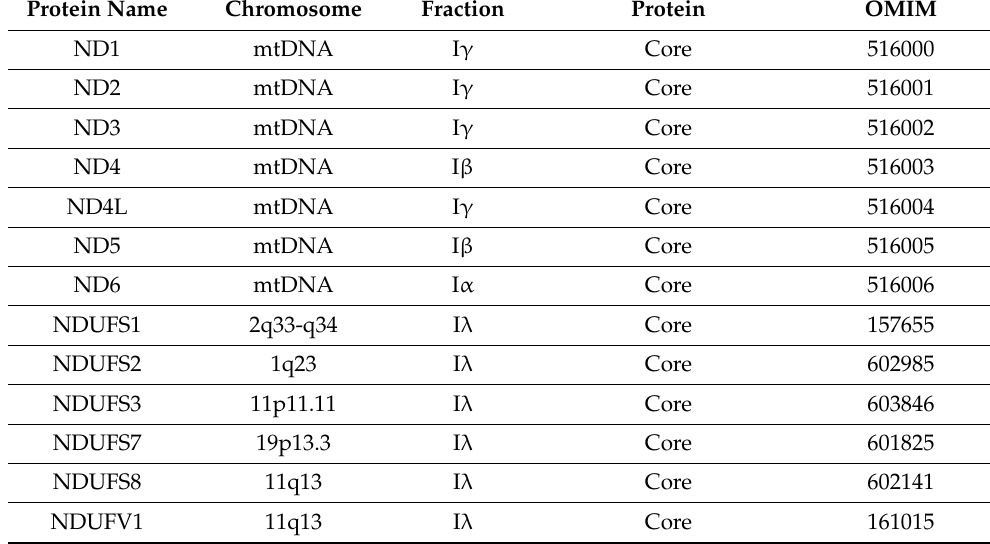
Table 1. Mitochondrial and nuclear encoded subunits, and (putative) assembly factors for human complex